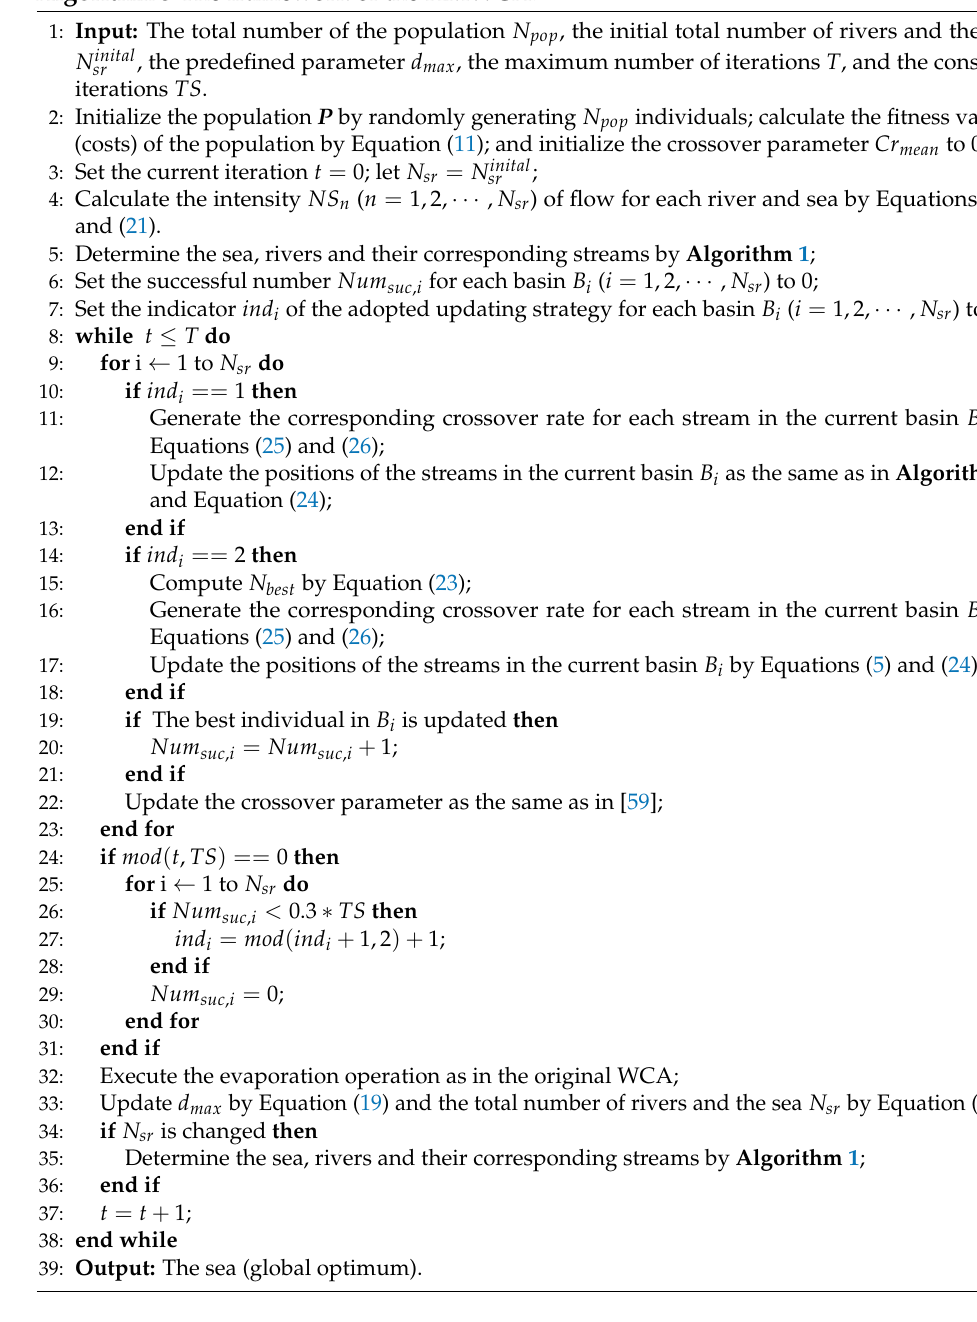
Algorithm 3 The framework of the